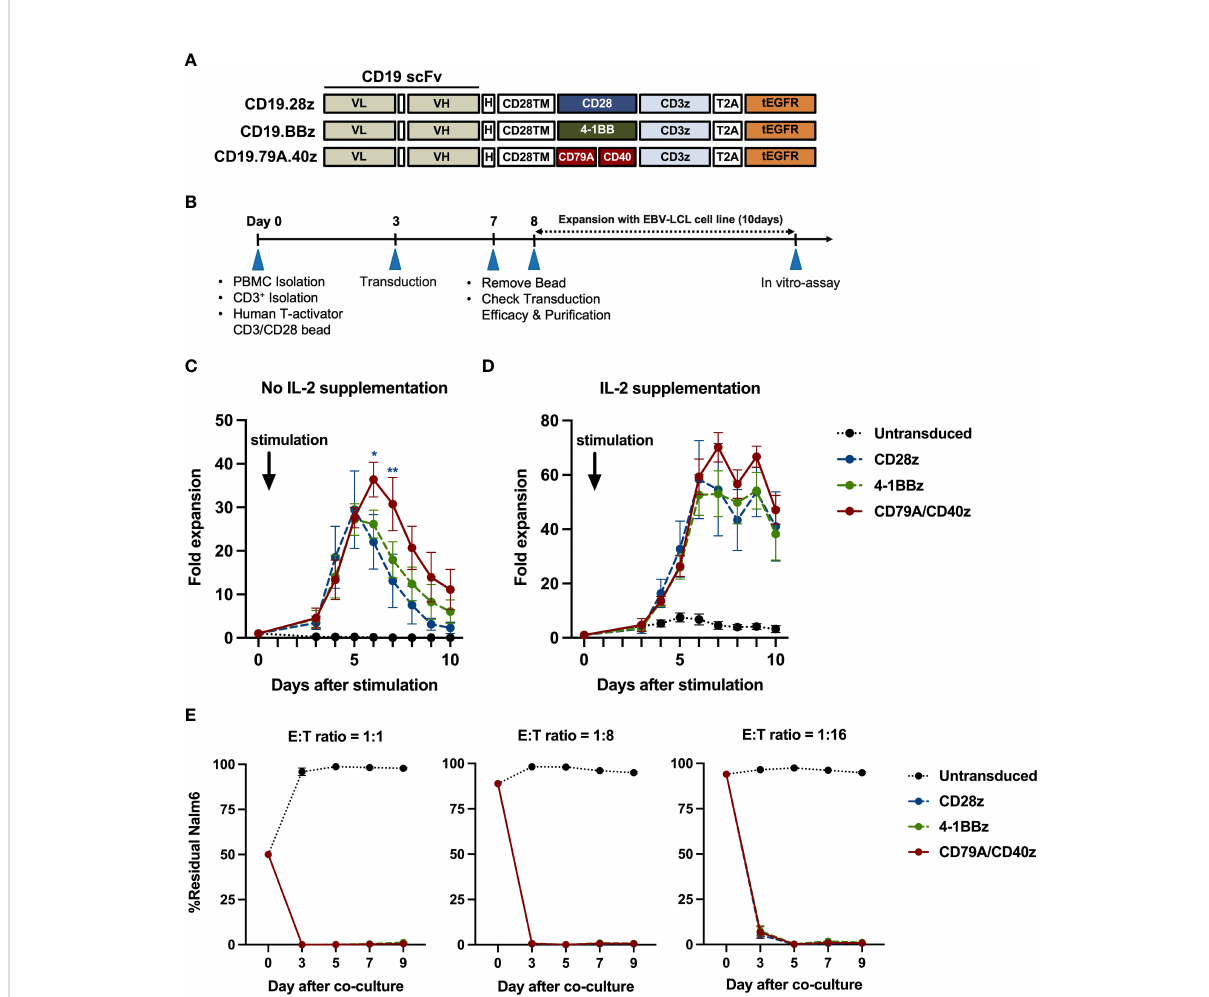
FIGURE 1 CD19CAR-T cell structure and CD19CAR-T cell response upon CD19 + target cell stimulation in an in vitro assay. (A) Schematic of CD19CAR-T cell structures. Each costimulatory domain either CD28 (CD28z), 4-1BB (BBz), or CD79A/CD40 (CD79A.40z) was fused into anti-CD19 scFv-H- CD28TM followed by CD3 z and tEGFR. scFv, single chain variable fragment; VL, light-chain variable fragment; VH, heavy chain variable fragment; H, short 12 amino acid of IgG4 Fc-derived spacer of hinge; TM, transmembrane domain; tEGFR, truncated EGFR. (B) Experimental schematic of CD19CAR-T cell generation and functional analysis. EBV-LCL, EBV-transformed lymphoblastoid cell line. (C, D) T-cell proliferation assay. Untransduced or CD19CAR-T cells were stimulated with g -irradiated CD19-K562 cell line in 1:1 ratio for 10 days and cultured without (C) IL-2 supplementation or with (D) IL-2 supplementation (50 IU/ml). T-cell proliferation were measured by counting viable cells. Arrows mark the day of CD19-K562 cell stimulation. (E) Prolonged co-culture assay. Untransduced or CD19CAR-T cells were co-cultured with Nalm6-FFluc at E: T ratios of 1:1 (left), 1:8 (middle), and 1:16 (right) for a total of nine days without exogenous IL-2. The remaining Nalm6-FF were assessed by fl ow cytometry at the indicated time points. All data were pooled from three different donors and are presented as mean ± SEM. 2-way ANOVA for (C, D) ; *p < 0.05, **p < 0.01 (CD19.79A.40zCAR- vs. CD19.28z CAR-T cells); One-way ANOVA for (E)